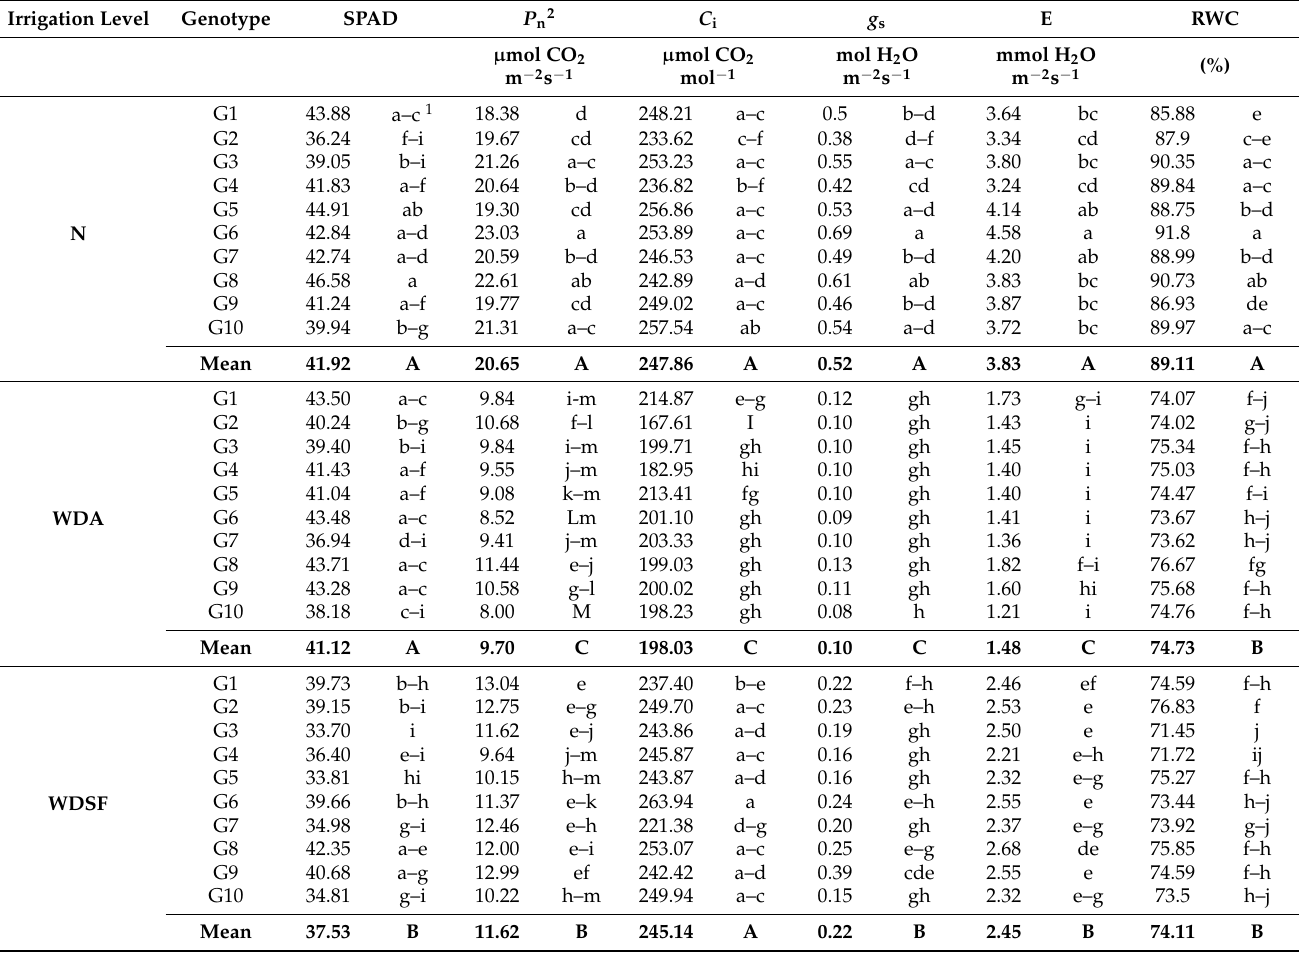
Table 3. Comparison of SPAD, P n , C i, g s, E, RWC parameters of ten bean genotypes as affected by three irrigation levels (N, normal irrigation conditions; WDA, water stress during anthesis; WDSF, water stress during seed filling stage) over two years